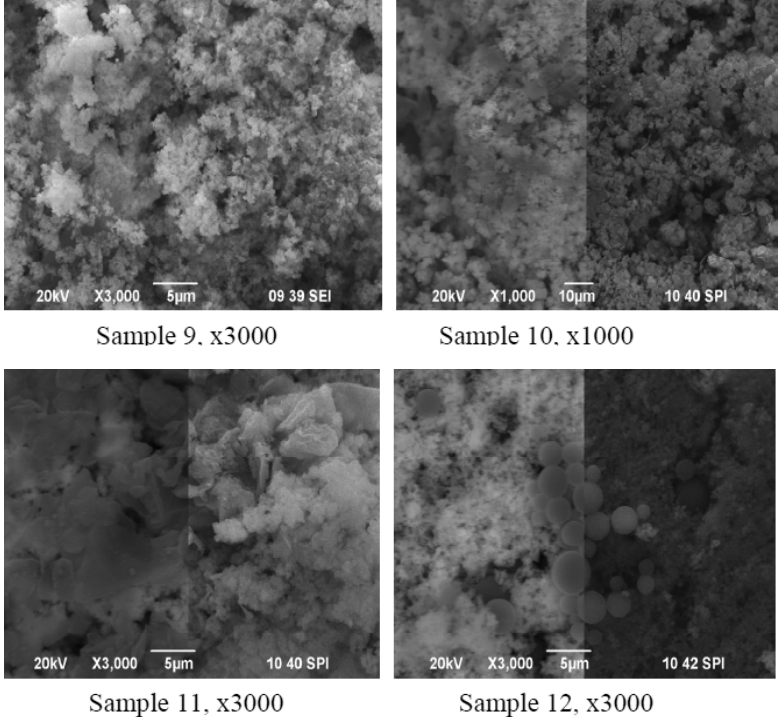
Fig. 3. SEM images at a different magnification of thesamples synthesized at a ratio Co:Ni=50:50: Sample 1-Co:Ni nanoparticles, Sample 2-Co:Ni nanoparticles/CF, Sample 3-Co:Ni nanoparticles/CF and  -CDx, Sample 4-Co:Ni